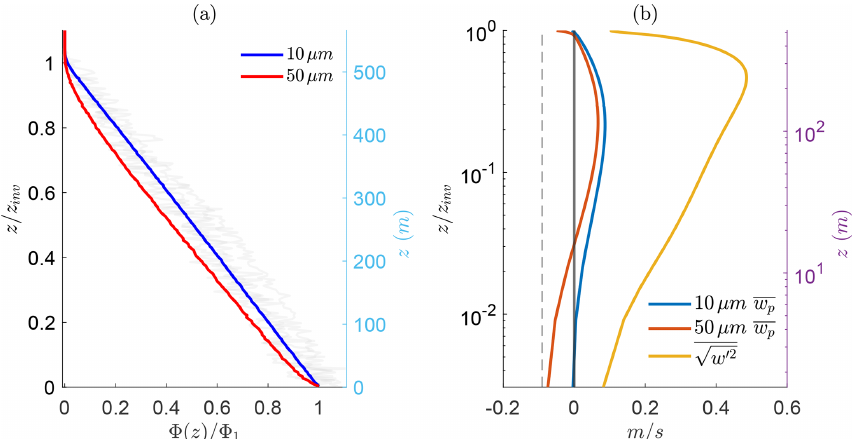
Figure 3. (a) Vertical flux profile for 10 and 50µm particles normalized by the respective flux at the first grid point ( (cid:56) 1 ). The three faded profiles are the instantaneous net fluxes at the start, middle, and end of the averaging time for 10µm particles. (b) Comparison of mean particle velocity for both sizes and the standard deviation of the flow vertical velocity at different heights (the left vertical axis is scaled by the inversion height, and the right side is the dimensional height). The dashed line is the gravitational settling velocity for 50µm